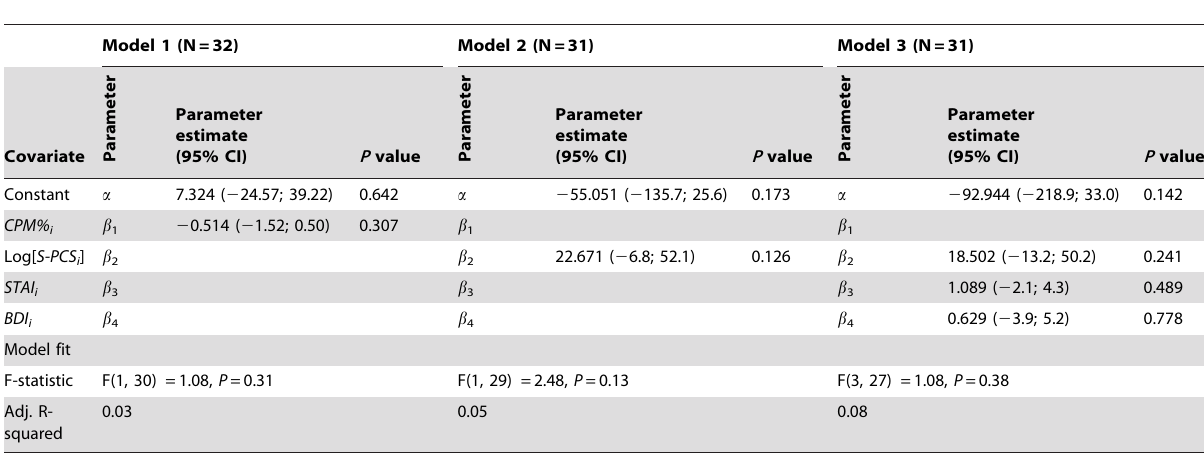
Table 5. Parameter Estimates from Regression Models of an Integrated Analgesic Assessment Score based on Morphine Consumption and Movement-evoked Pain Intensity Scores ( 2 200 to + 200%) against Conditioned Pain Modulation, Situational Pain Catastrophizing, Anxiety, and Depression.